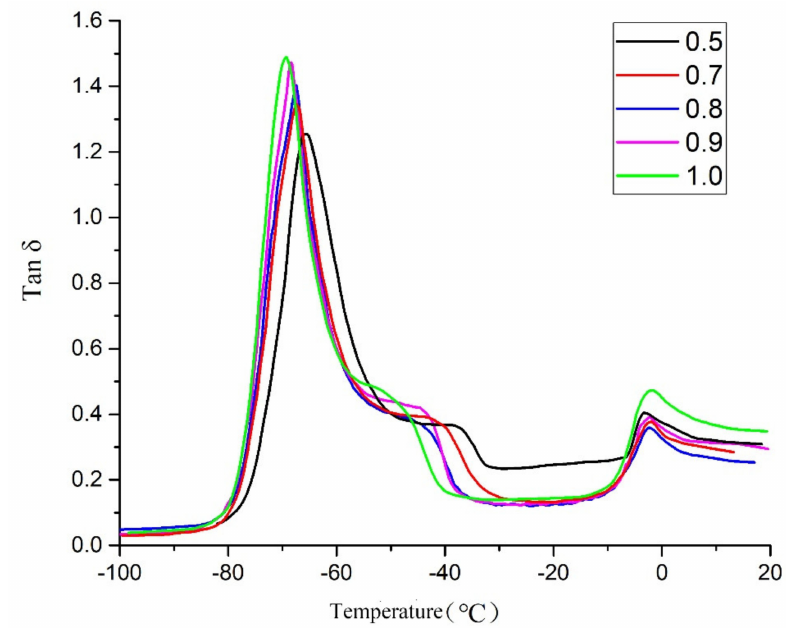
Figure 6. The tan δ curves of